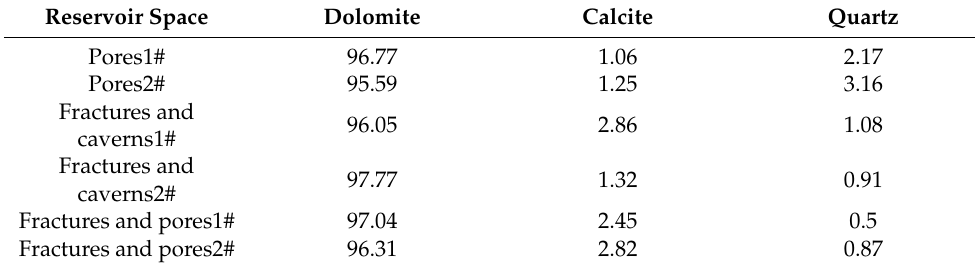
Table 1. Mineral components of rock cores with different reservoir space.